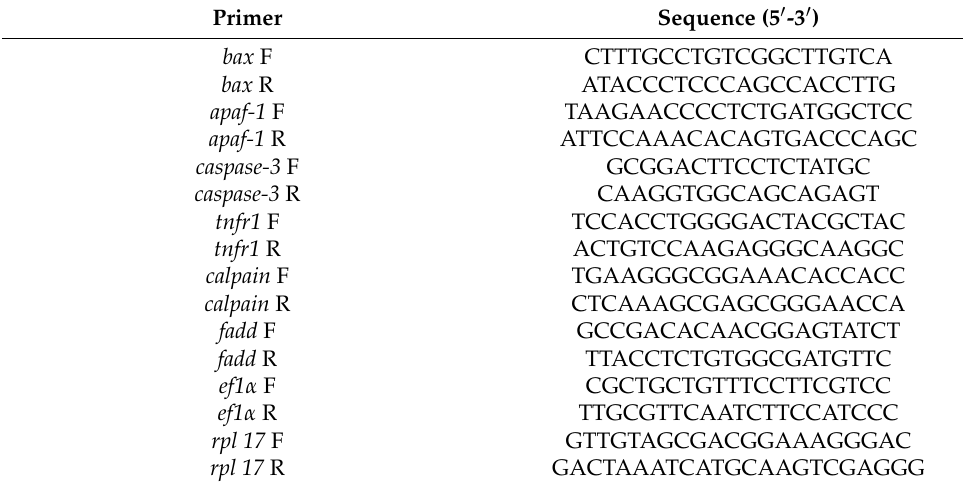
Table 2. Primers used for real-time quantitative PCR